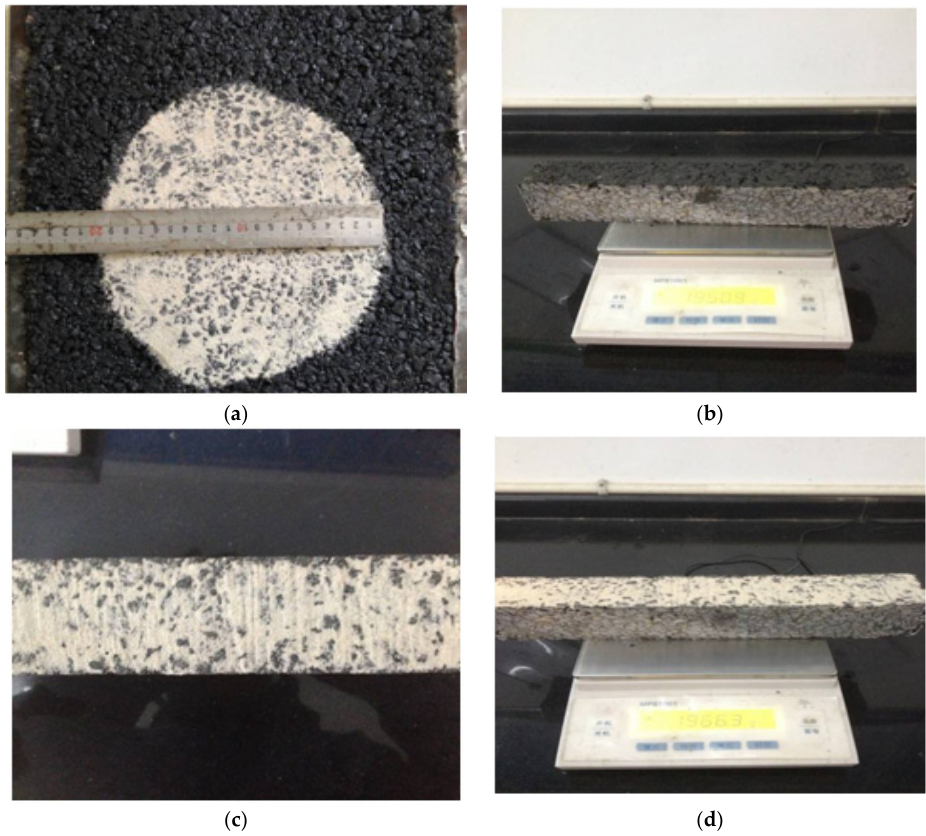
Figure 2. Test processes for combined texture depth test and wheel loading test: ( a ) measuring K 0 for the specimen of wheel loading test; ( b ) measuring m 1 for the cut strip specimen; ( c ) laying sands on the top surface of the strip specimen; ( d ) measuring m 2 for the strip specimen with sands.